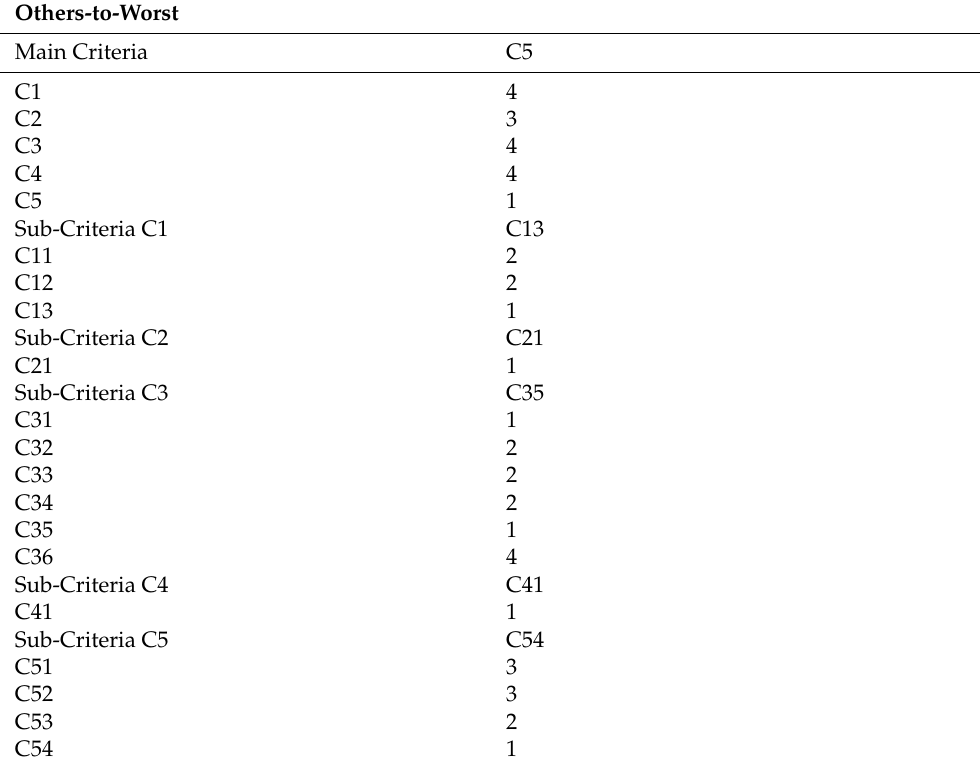
Table 5. Others-to-Worst vectors as derived from expert evaluations.